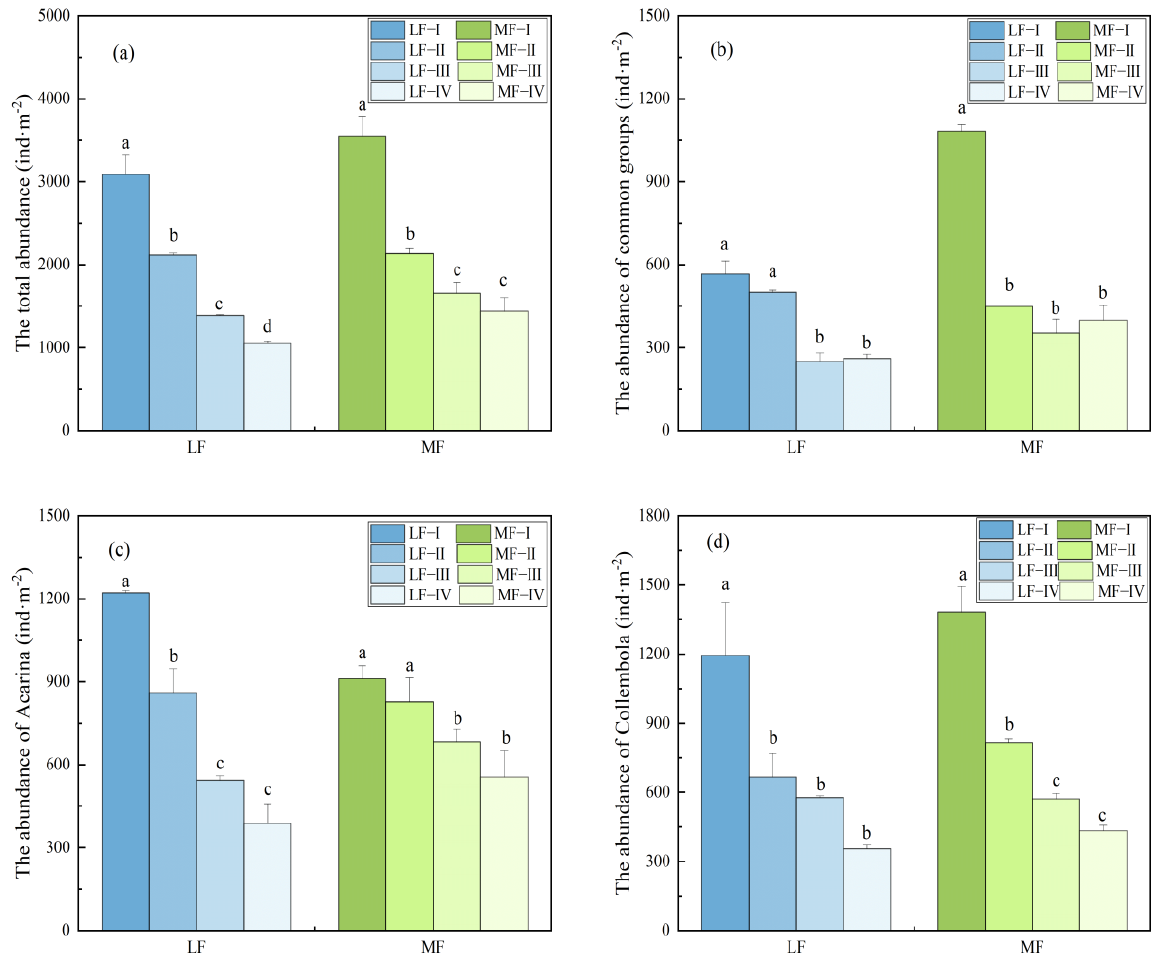
Figure 2. Vertical distribution of the soil fauna community. ( a ) The total abundance; ( b ) the abundance of common groups; ( c ) the abundance of Acarina; ( d ) the abundance of Collembola. Different letters indicate significant differences between soil layers of the same forest at the 0.05 probability level.